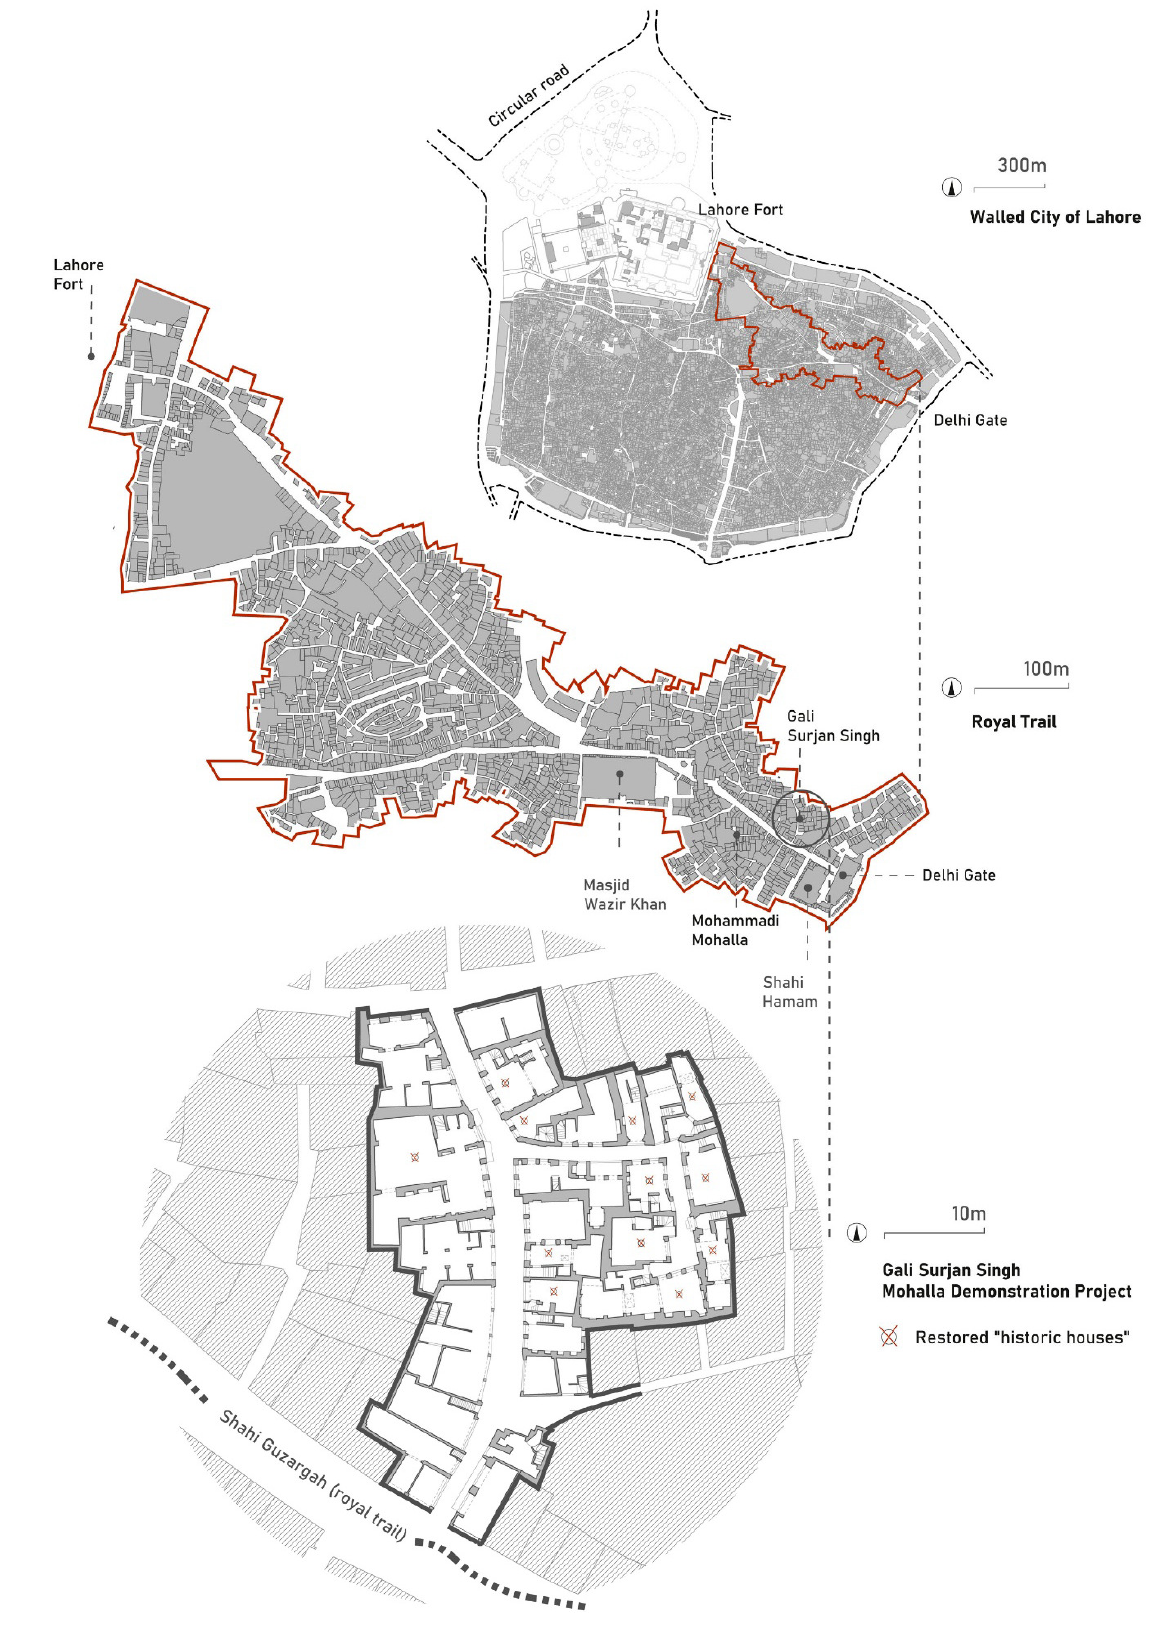
Figure 7. Walled City, Royal Trail area and Mohalla Gali Surjan Singh. Source: Figure by Helena Cermeño (2022); the maps are based on data by the WCLA, AKTC, and AKCS‐P collected in Jodidio